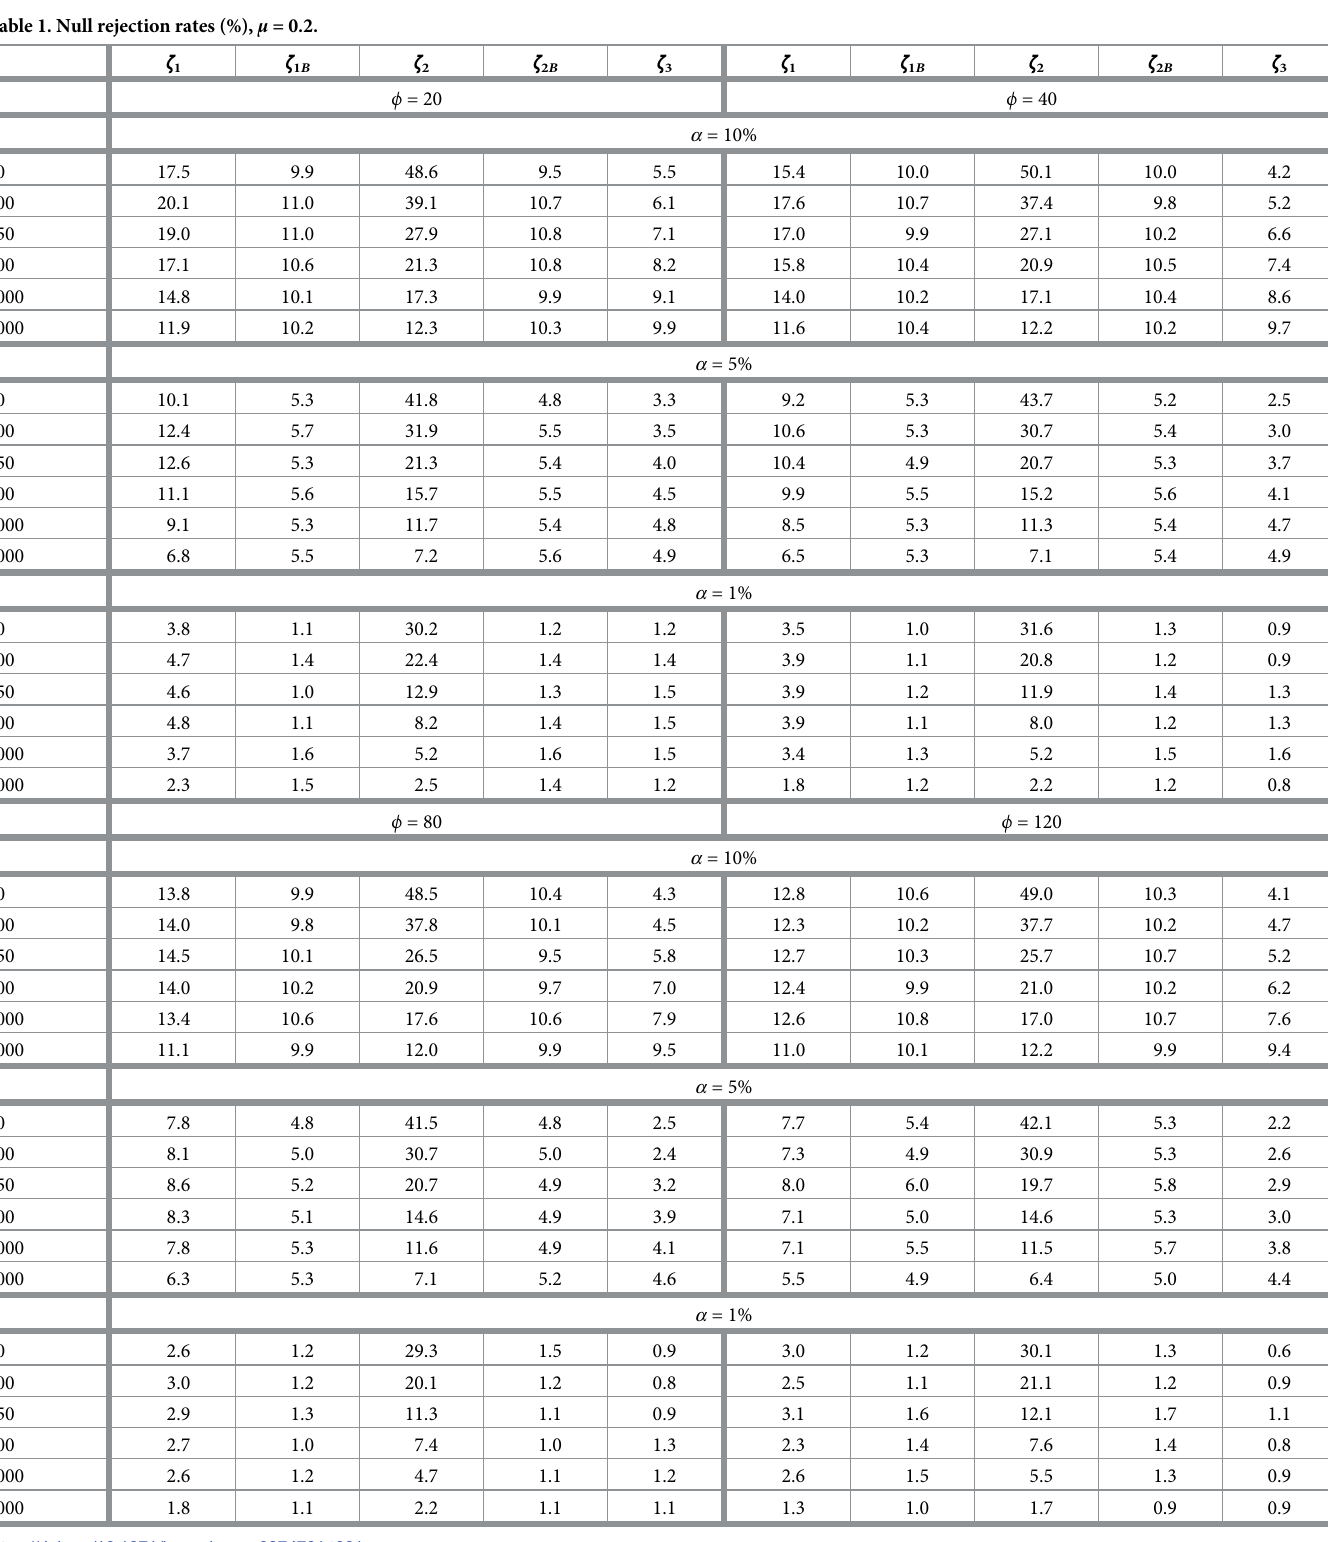
Table 1. Null rejection rates (%), μ =